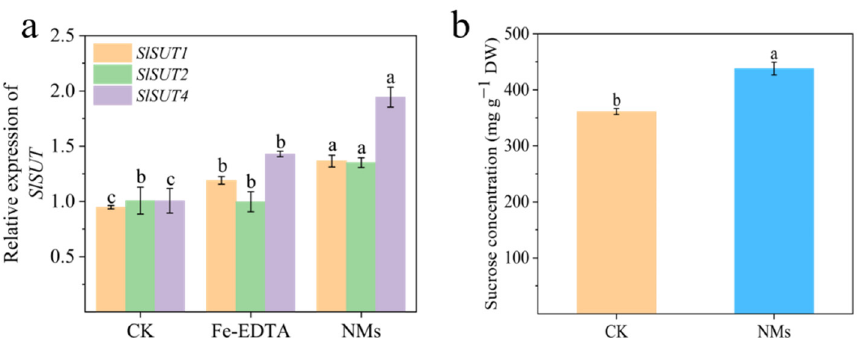
Figure 5. Relative expressions of sucrose transporter genes ( a ) and sucrose content in tomato fruits ( b ) Different letters in represent significance of p <